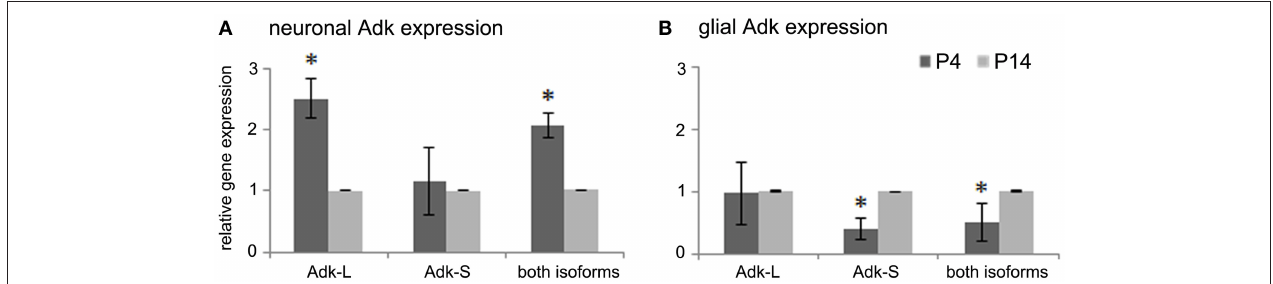
FIGURE 1 | Adk gene expression in early postnatal brain development. (A) Adk gene expression of long and short Adk isoforms separately as well as total Adk expression in rat hippocampal neurons and (B) in rat hippocampal glial cells at postnatal days 4 and 14 (P4 and P14, respectively) is shown. Adk gene expression was calculated relative to internal reference gene GAPDH. Neuronal and glial Adk gene expression at P4 was normalized to respective expression at P14, which was always set at 100%. Adk-L - long Adk isoform; Adk-S - short Adk isoform. *indicates